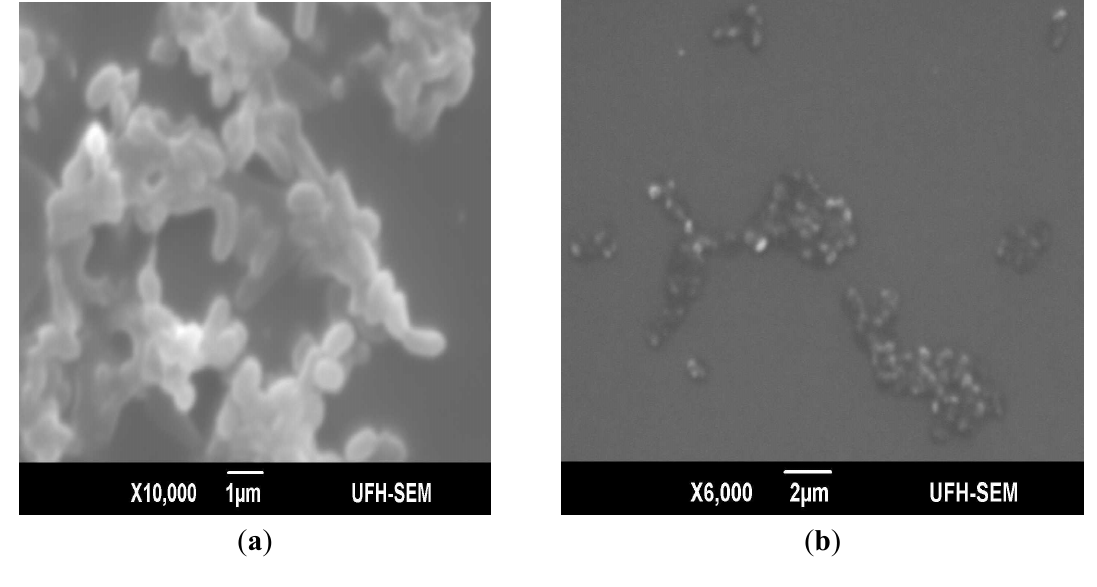
Figure 1. Scanning electron micrographs of an autoaggregate and coaggregate biofilm of E. cloacae and its coaggregate partner P. aeruginosa ATCC 15442 ( a ) strong adherent autoaggregate; ( b ) coaggregate of E. cloacae and partner P. aeruginosa ATCC